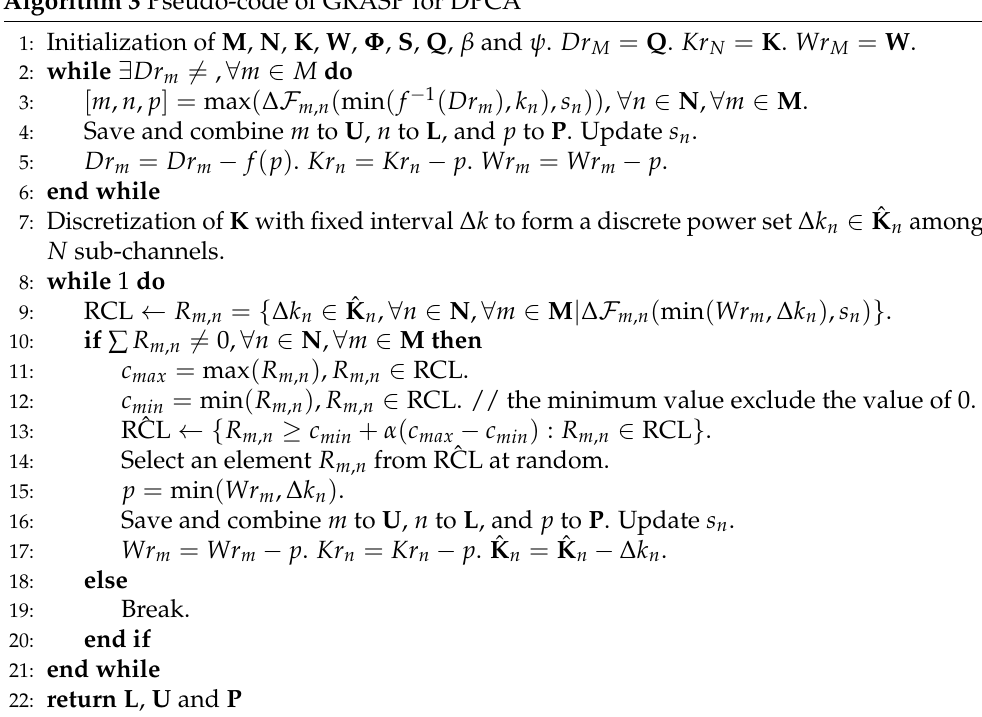
Algorithm 3 Pseudo-code of GRASP for